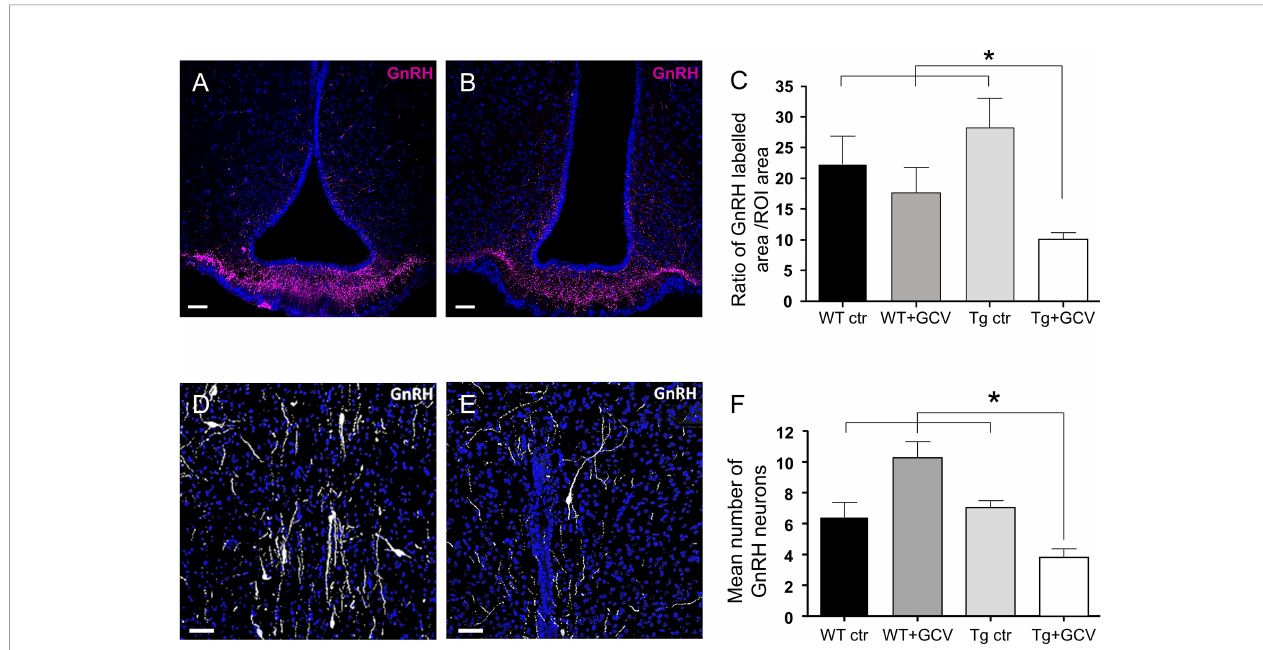
FIGURE 5 | Effect of central GCV administration in Tg mice on GnRH immunoreactivity in the preoptic region and the median eminence. (A, B) Representative images of GnRH fi bers in the median eminence of control (A) and Tg+GCV (B) male mice. Statistical analysis revealed a signi fi cantly decreased GnRH expression in Tg+GCV mice as compared to the three control groups (C) . (D, E) Representative images of GnRH neurons in the preoptic area (POA) of control (D) and Tg+GCV (E) male mice. (F) Mean number of GnRH neurons in the POA per slice, n ≥ 3 slices per group. Statistical analysis revealed a signi fi cantly decreased GnRH neuron number in the POA in Tg+GCV male mice (F) . Nuclei coloration with Hoechst (blue). Data are expressed as the mean ± SEM. *p<0.05. Scale bars, 20